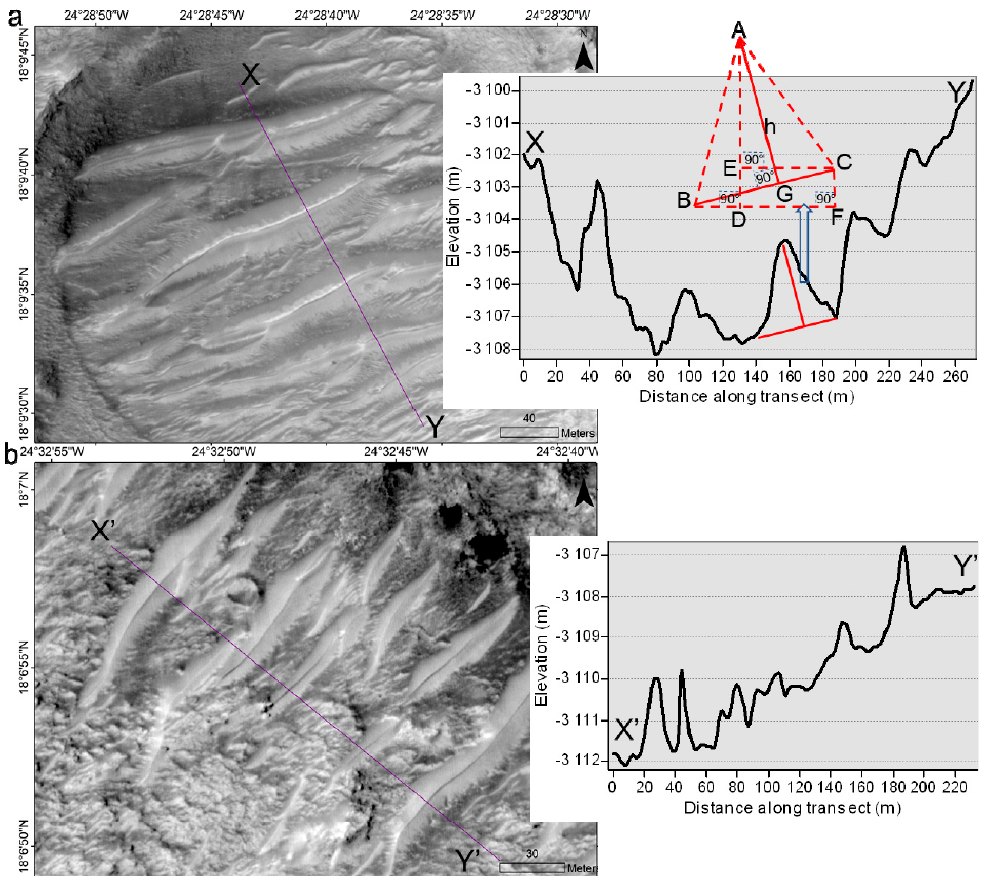
Figure 8. Examples of transect (violet lines overlaid on HiRISE image) analysis and TAR height (h) estimations: ( a ) a transect for TARs with W > 150 m and within a confined space (i.e., crater), ( b ) a transect for TARs in a relatively open space. The elevation profile is derived from the HiRISE DTM DTEEC_009880_1985_009735_1985_L01 and HiRISE image PSP_009735_1985 is in the background. HiRISE image and DTM credit: NASA / JPL / University of